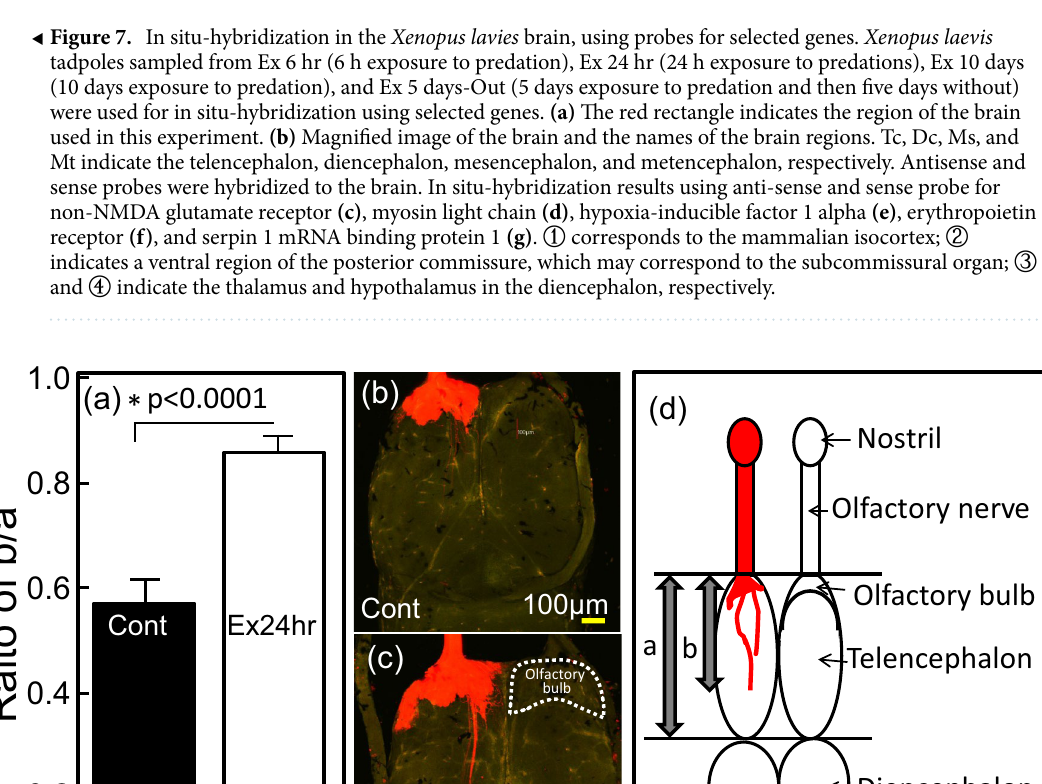
Figure 8. Extension of the axons in the brains of Xenopus laevis tadpoles exposed to the Japanese predatory larval salamanders, Hynobius lichenatus for 24 h. (a) Ratio of the extended axons per telencephalon compared with the control (Cont.; not exposed to Japanese predators) was calculated as b/a (a: length of telencephalon; b: length of the extended axons) in the brain. Statistical analysis ( t -test) on the data were performed with SPSS. (b) Tadpoles not exposed to a predator (c) Tadpoles exposed to Japanese predator for 24 h. (d) Schematic profile of a tadpole’s brain stained by